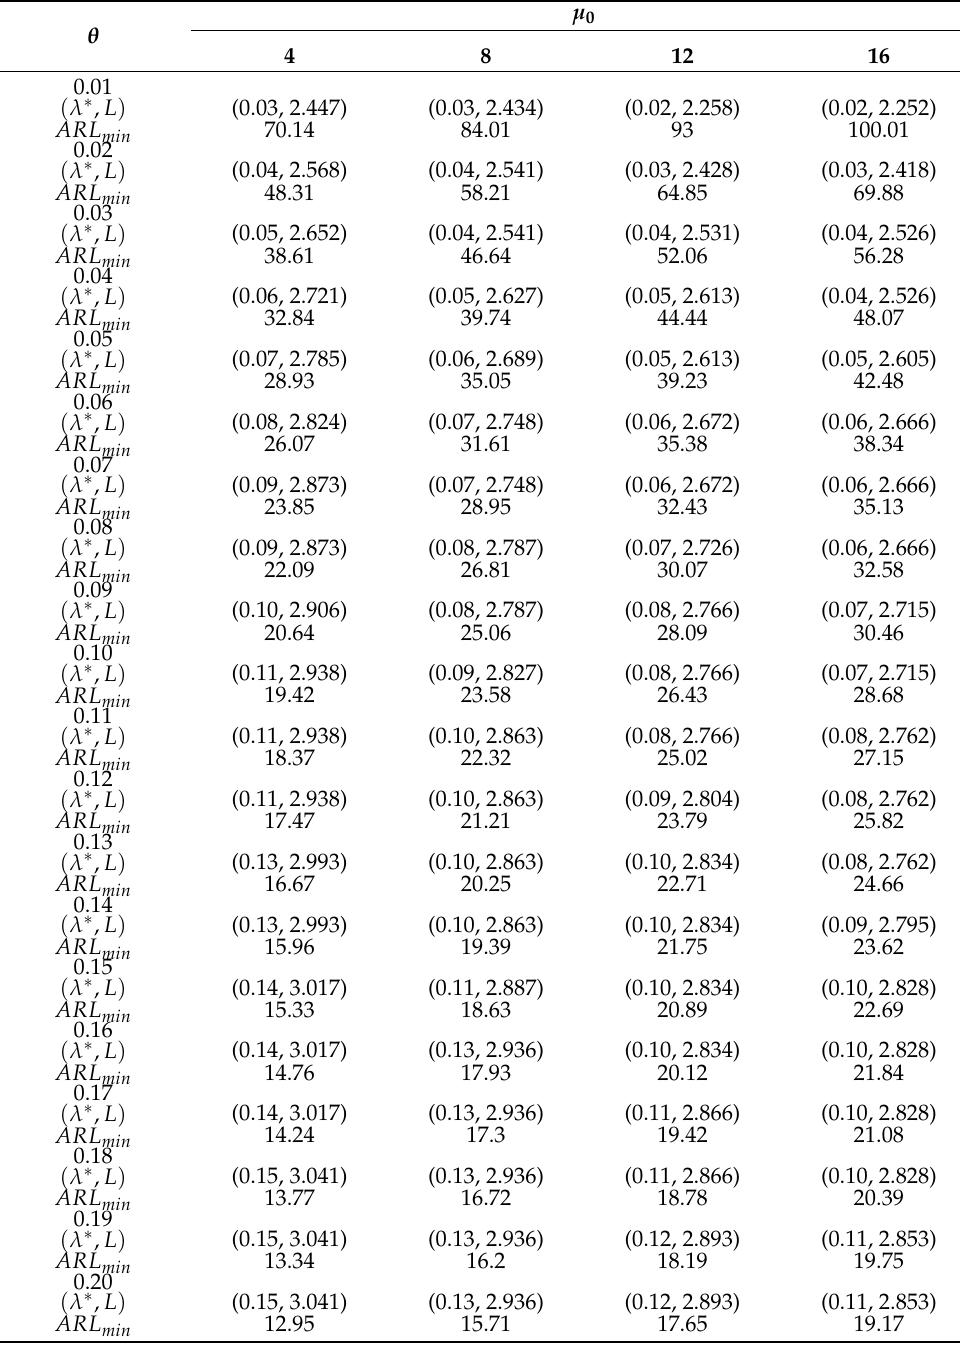
Table 4. Optimal parameters for the EWMA chart when ARL 0 =